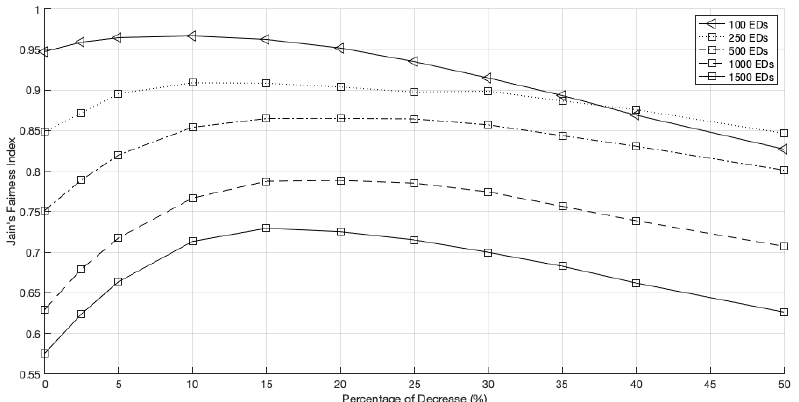
Figure 14. Network fairness for 3 GWs, different network sizes and different PoD.